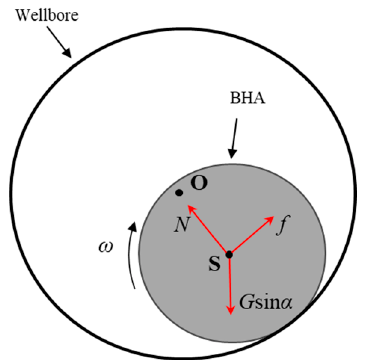
Figure 8. Schematic diagram of lateral force.